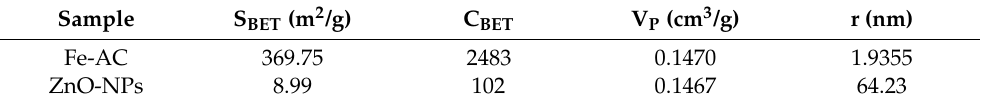
Figure 5. Nitrogen-adsorption isotherms of ( a ) Fe-AC and ( b ) ZnO-NPs samples at − 196 °C . Table 1. Textural properties of prepared samples from nitrogen adsorption at − 196 °C.